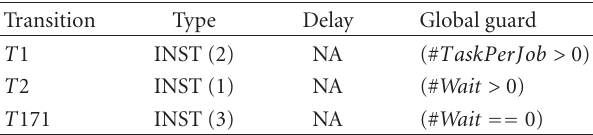
Table 12: Open system model Petri net transition